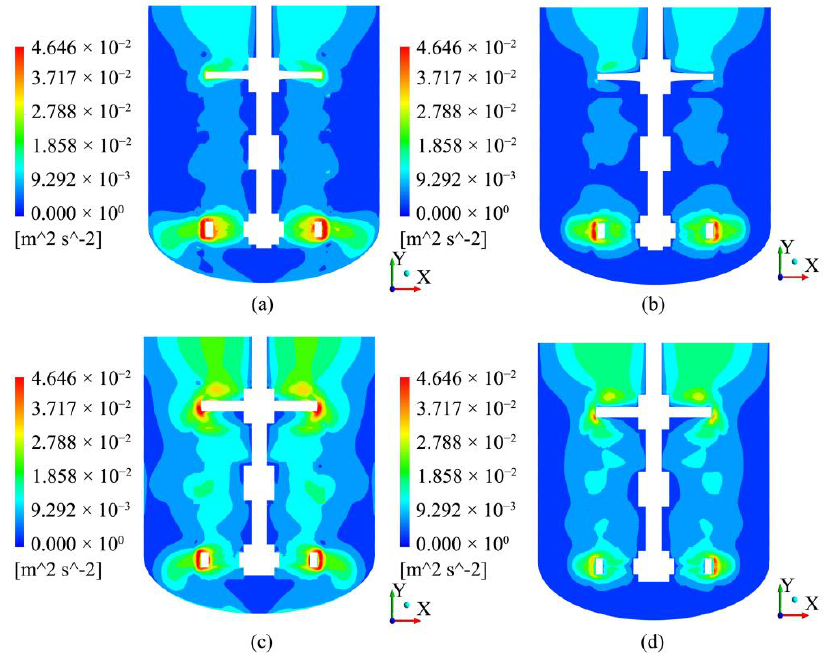
Figure 17. Cloud diagram for the turbulent kinetic energy in the XY section. ( a ) Re = 2316.5, µ = 0.023 Pa · s, TBC-A type agitator; ( b ) Re = 44,910, µ = 0.001 Pa · s, TBC-A type agitator; ( c ) Re = 2316.5, µ = 0.023 Pa · s, TBC-B type agitator; ( d ) Re = 44,910, µ = 0.001 Pa · s, TBC-B type agitator.